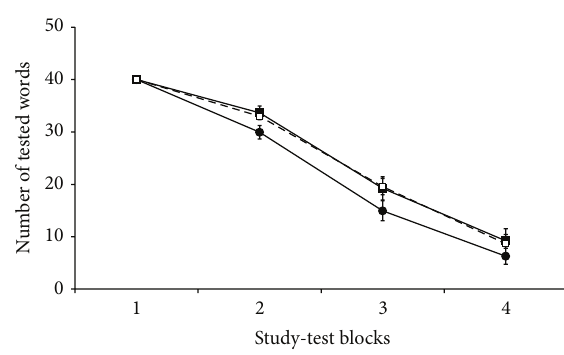
Figure 2: Average number of presented word pairs in the four experimental blocks (first/main session). All participants started with 40 pairs and, as participants correctly remembered them, the number of presented pairs decreased. Filled circles indicate parietal stimulation, filled squares indicate frontal stimulation, and empty squares indicate sham stimulation. Error bars represent the ±